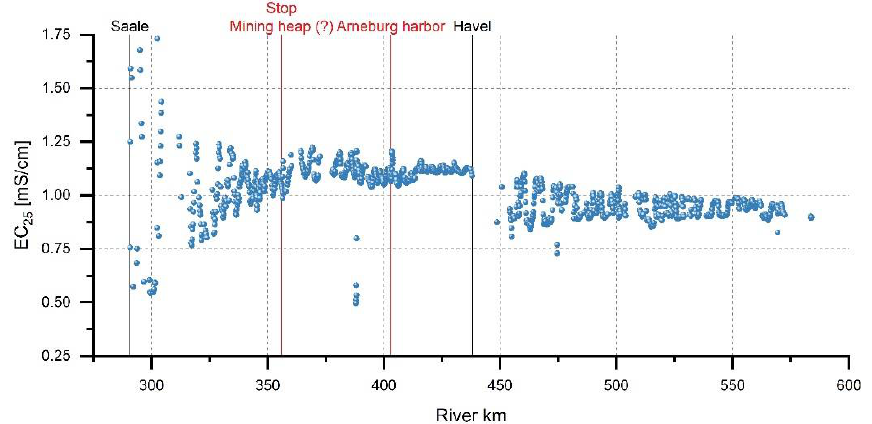
Figure 13. EC 25 plotted against river km of the Elbe. Only the investigated stretch of the Elbe River after the mouth of the Saale is depicted. Major tributaries are marked with black lines. Red lines mark a noticeable increase in EC 25 unrelated to tributaries. The recorded EC 25 values show generally high variations in this part of the Elbe River.